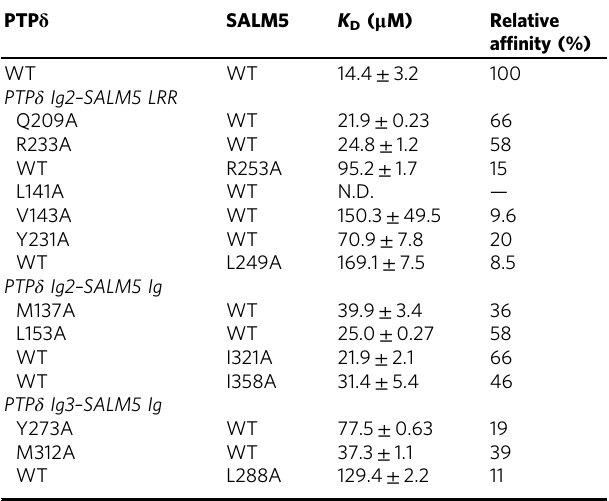
Table 3 Binding af fi nities between PTP δ (Ig1 – Fn1) and SALM5 (LRR –